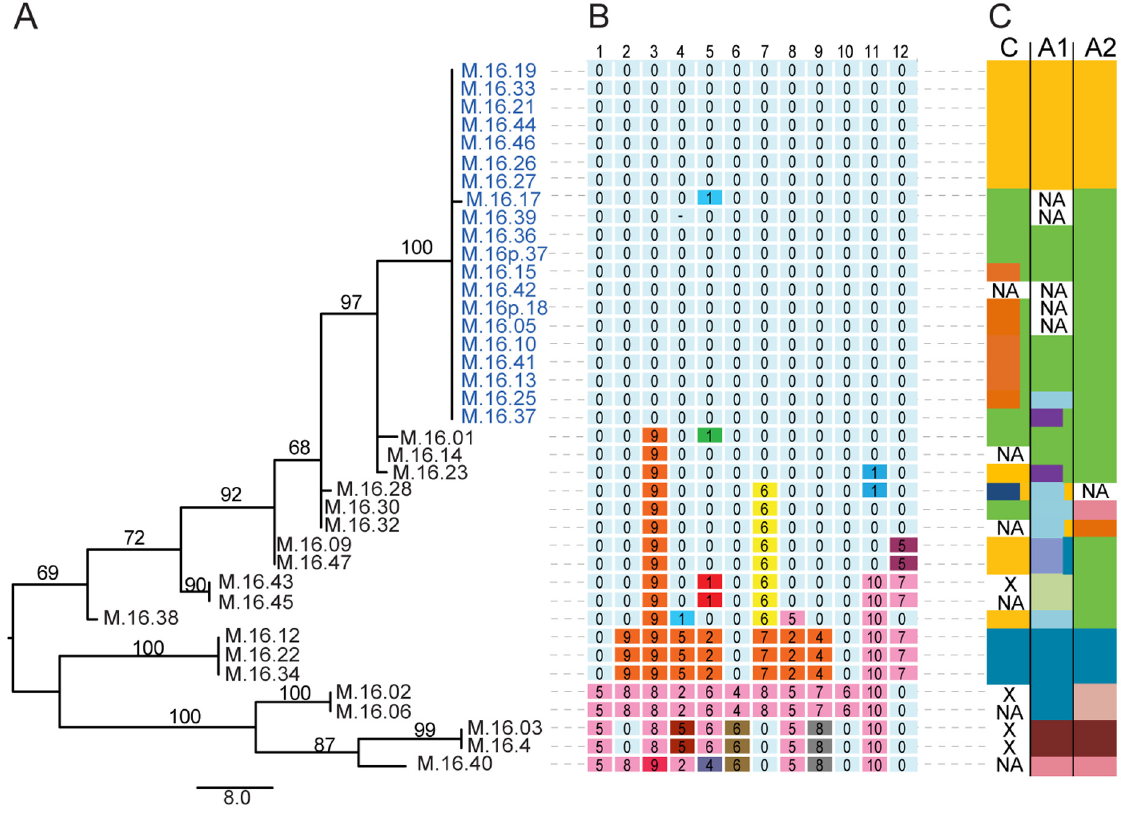
Figure 1. Core gene phylogeny and MLSA allelic profiles compared to CRISPR spacer types. (A) A Maximum Parsimony phylogeny of a concatenated nucleotide alignment of 12 loci (6684 bp) from 39 S. islandicus isolates from a single hot spring in Mutnovsky. Scale bar represents eight nucleotide changes. Numbers above branches represent bootstrap support from 1000 replicates. The large group of strains with nearly identical MLSA sequences at core gene loci is highlighted in blue. (B) The allelic profiles of MLSA loci show the number of SNPs in comparison to strain M.16.19, and the background color in each cell indicates the allele type for each locus. (C) The three colored summary bars to the right of the allelic profiles indicate ancestral groupings of each CRISPR locus by shared spacers as in Figure 2. ‘X’ indicates a CRISPR locus is not present and ‘NA’ indicates that a locus could not be sequenced.